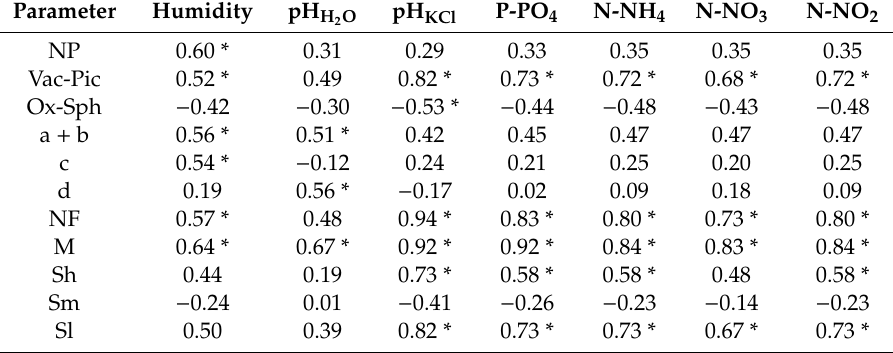
Table 8. Pearson correlation (R - coe ffi cient) between plants, macromycetes and habitat parameters.